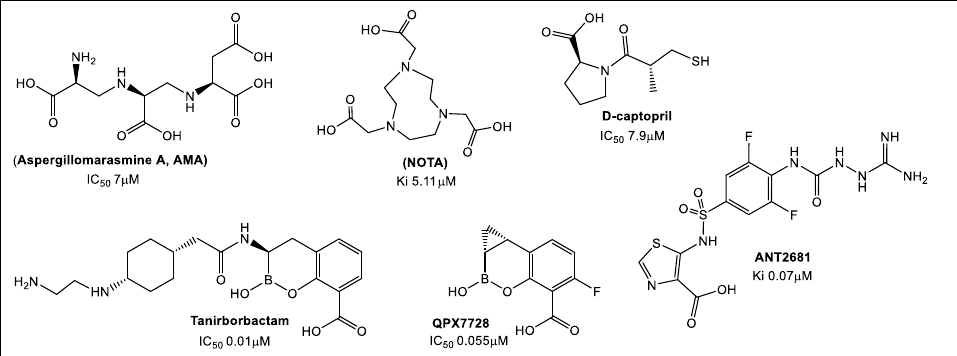
Figure 1. Representatives of the estimated 500 natural and synthetic inhibitors of metallo- β -lac- tamases.